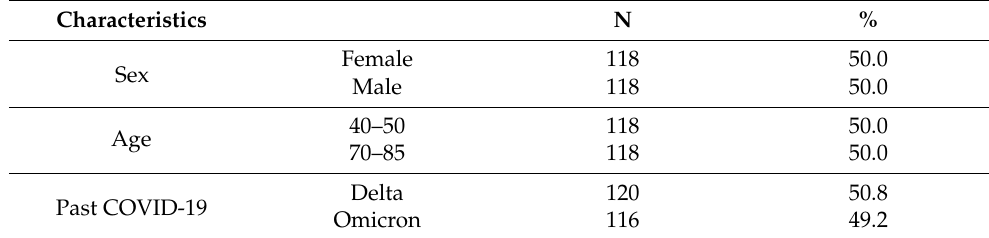
Table 1. Characteristics of studied individuals.